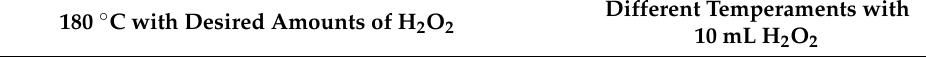
Table 2. Physicochemical properties of the mesoporous CeO 2 synthesized hydrothermally at 180 ◦ C for 24 h with a desired amounts H 2 O 2 of 2, 5 and 10 mL, and the mesoporous CeO 2 synthesized hydrothermally at a set temperature of 140 and 200 ◦ C for 24 h with 10 mL H 2 O 2 . 180 ◦ C with Desired Amounts of H 2 O 2 Synthesis Conditions